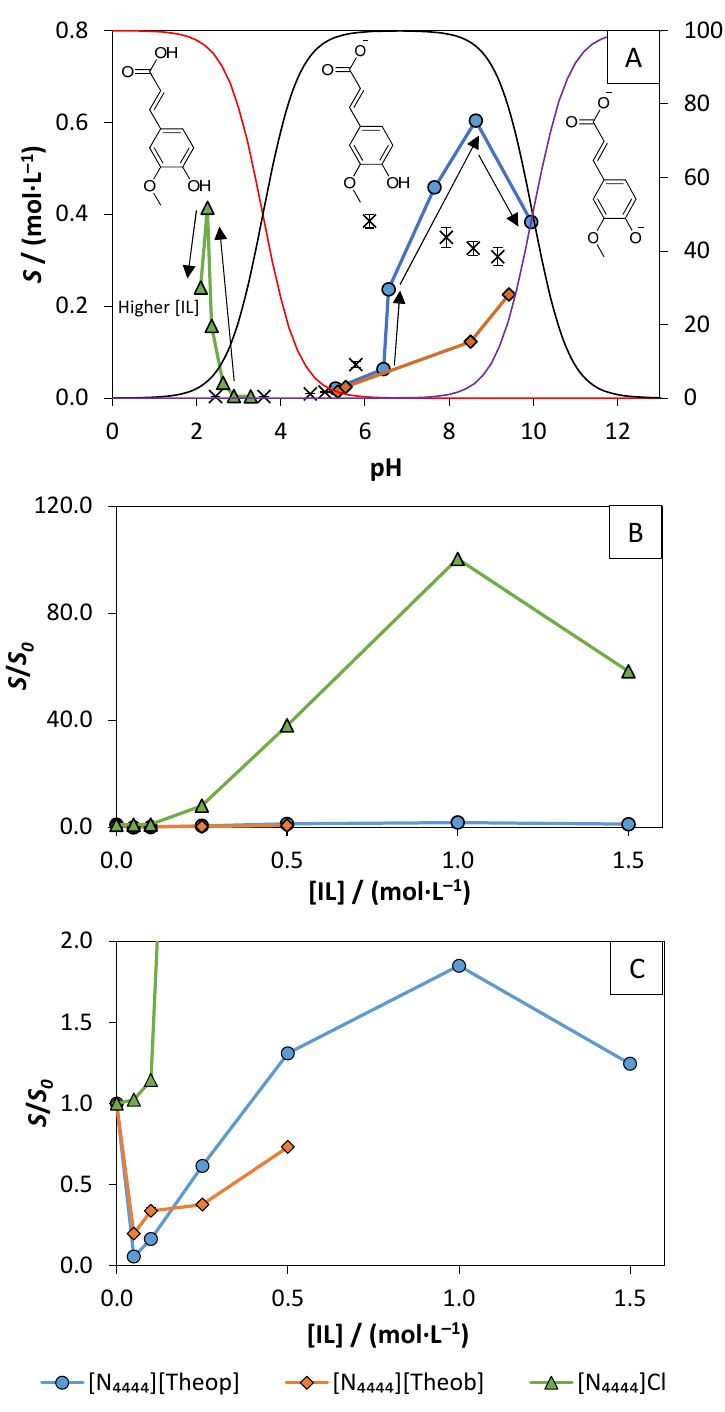
Figure 7. ( A ) Ferulic acid molar solubility, left axis, throughout the pH of the saturated samples with IL concentrations ranging from 0.05 to 1.5 mol · L − 1 : water-solubility of ferulic acid at that pH ( × ); [N 4444 ][Theop] (blue o), [N 4444 ][Theob] (orange ◊ ), and [N 4444 ]Cl (green Δ ). The red, black, and purple curves represent the deprotonation percentage of ferulic acid, right axis (data from Marvin 21.14 [59]). The arrows point to IL concentration increase. ( B ) Molar aqueous solubility enhancement (S/S 0 ) of ferulic acid in [N 4444 ][Theop] (blue ○ ), [N 4444 ][Theob] (orange ◊ ), and [N 4444 ]Cl (green Δ ) solutions at different molar concentrations, with S 0 being the water-solubility of ferulic acid at a similar pH to that of the saturated sample; ( C ) y -axis zoom of ( B ).